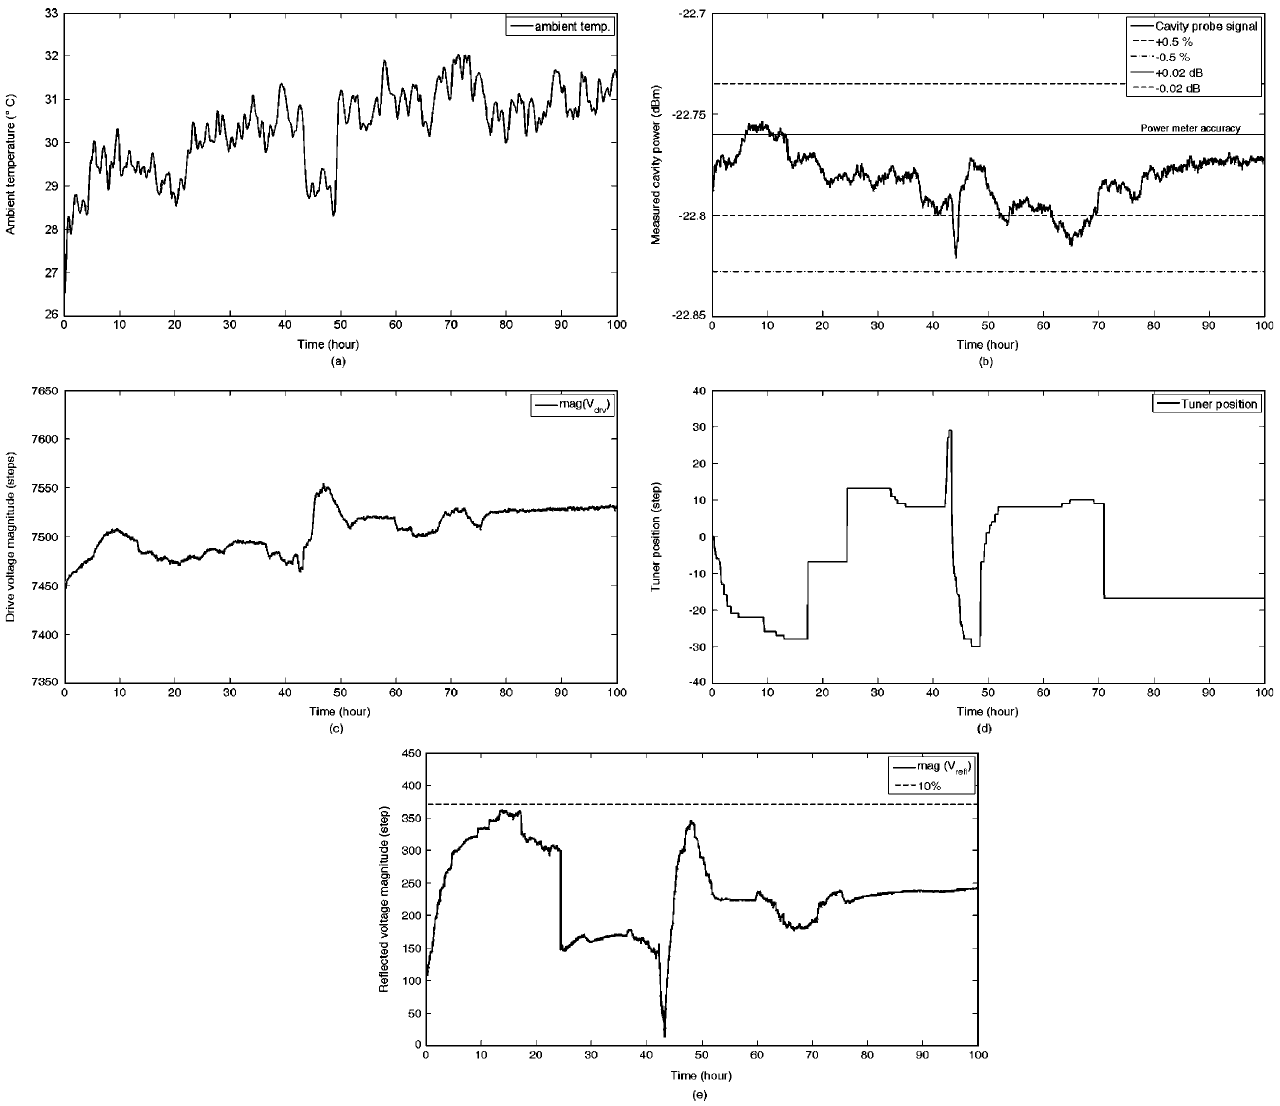
FIG. 16. 100-hour long-term stability measurements. From top to bottom: (a) ambient temperature, (b) measured cavity power, (c) cavity drive voltage (LLRF output), (d) tuner position, and (e) reflected voltage. The steps in cases (c) and (e) correspond to the DAC/ADC counts. In (d), the steps correspond to the pulses sent to the stepper